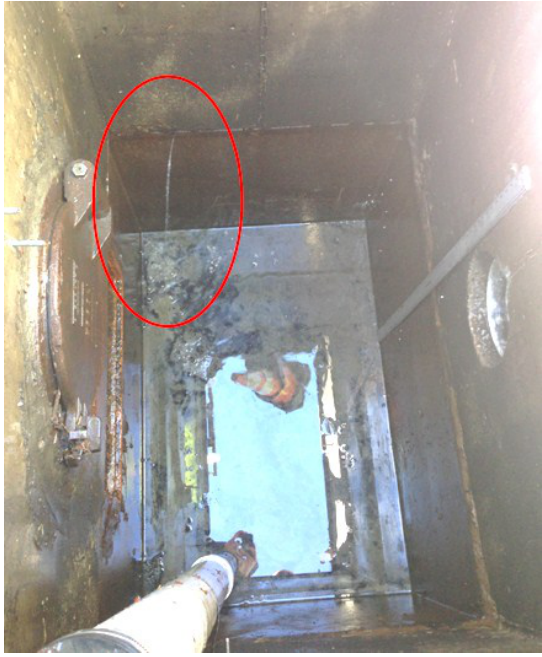
Figure 6. Leaking point in the inlet structure (Date: 25 January 2017).